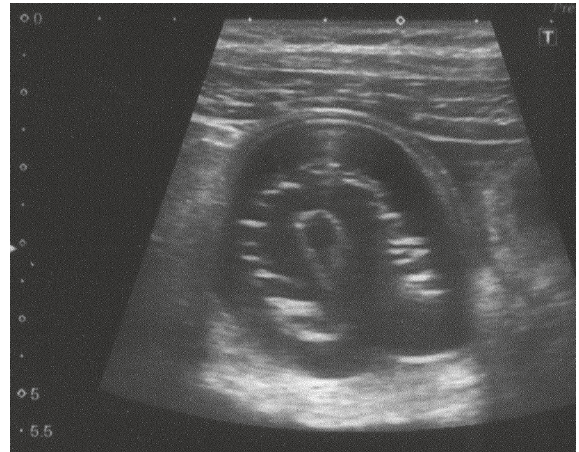
Figure 2: Abdominal ultrasonography revealed an apple-shaped foreign